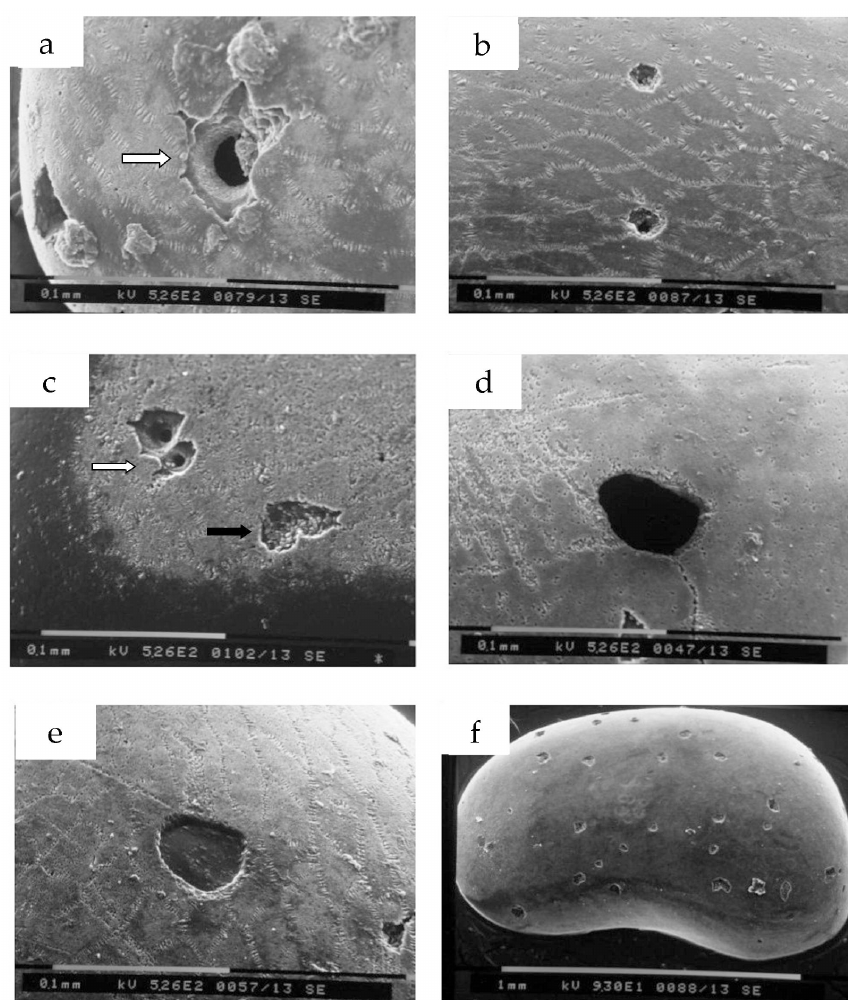
Figure 5. Examples of different type of perforations. ( a – e ) Scale bar = 100 μ m. ( f ) Scale bar = 1 mm.